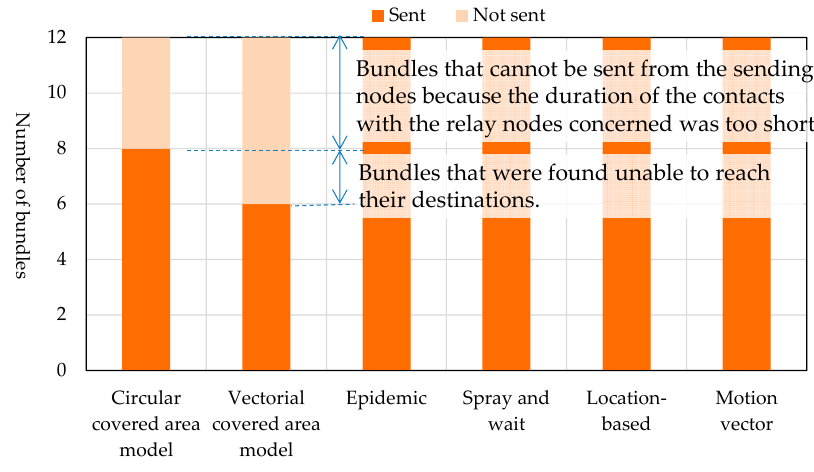
Figure 21. Number of bundles that were sent from sending nodes.